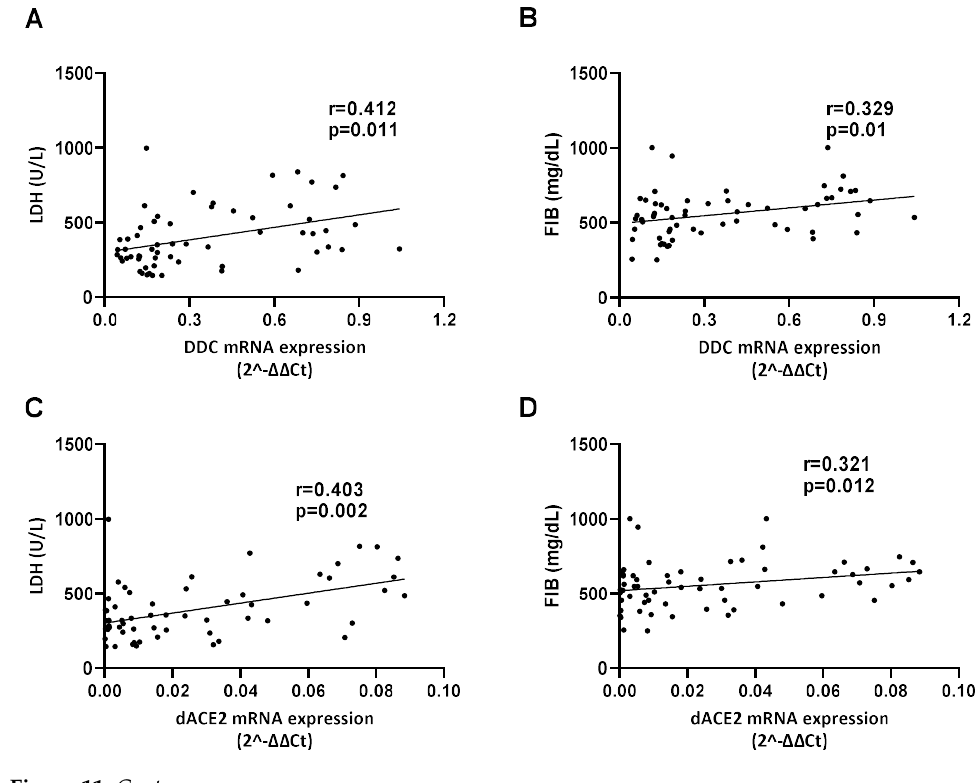
Figure 11. Correlation between the mRNA levels of ( A,B ) DDC , ( C,D ) dACE2 , and ( E,F ) MAOA with the protein levels of LDH and FIB respectively, in whole blood samples of hospitalized COVID- 19 patients. Data are presented as XY scatter plots and fitted linear regression lines. Pearson’s or Spearman’s correlation coefficient (r) and p -values (p) were calculated.